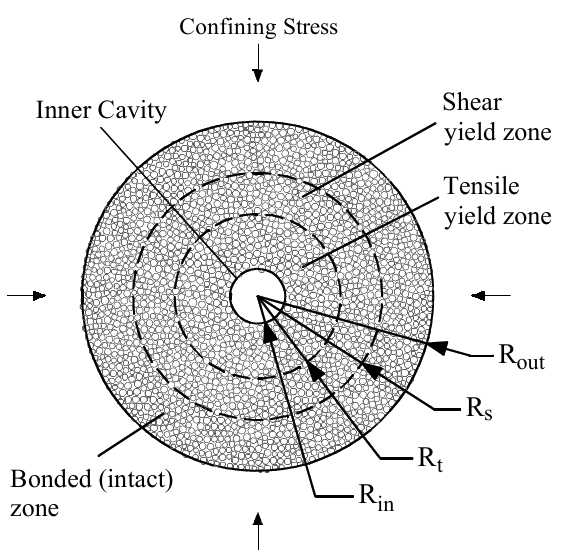
Figure 15. Schematic diagram of zones surrounding a spherical cavity and the definition of the radius of each zone.